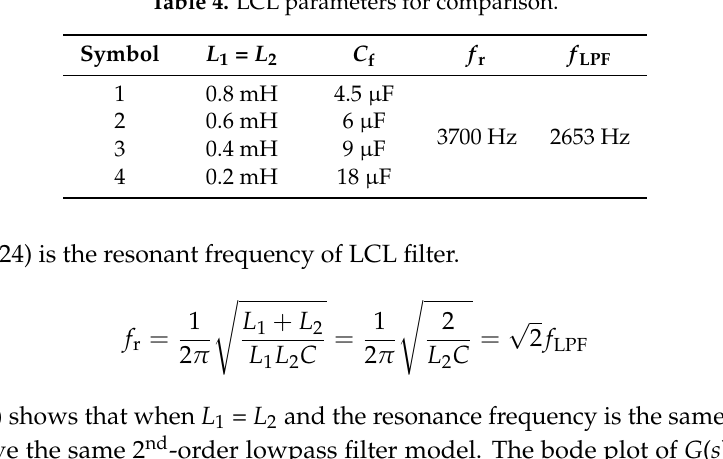
Figure 9. Energies 2018 , 11 , x